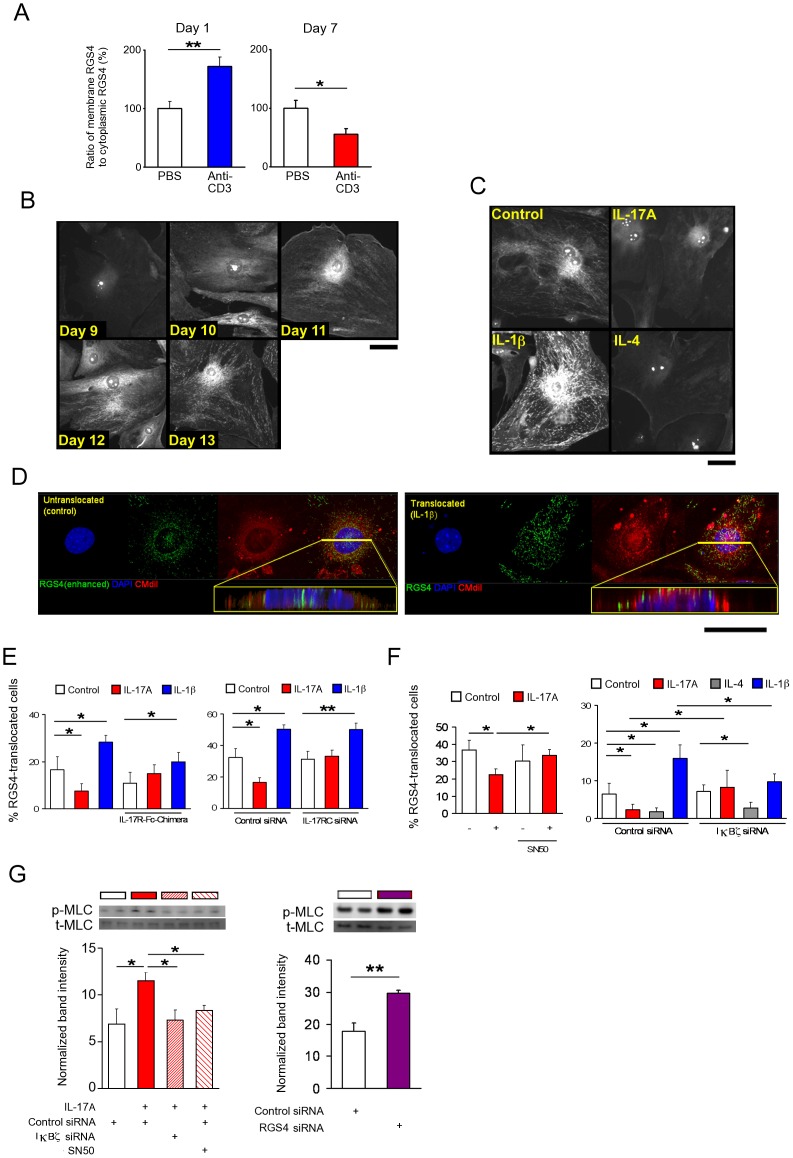
The effect of IL-17A on IκBζ - RGS4 signaling.(A) RGS4 activity in samples of MS isolated from the mice treated with PBS or αCD3. RGS4 activity was estimated as the ratio of membrane RGS4 to cytosolic RGS4 as described in Materials and Methods. In the inflammatory phase (Day 1) RGS4 activity was enhanced while in the recovery phase (Day 7) the activity was decreased (n = 8). (B) Immunofluorescence staining of RGS4 protein. The days from the beginning of the culture are indicated. Scale bar, 50 µm. (C) Immunofluorescence staining of RGS4 protein after treatment with IL-17A, IL-1β or IL-4 for 24 hrs. Scale bar, 50 µm. (D) Three dimensional reconstruction of laser confocal microscopic images of cultured SMCs treated with IL-1β (right panel) and control (left panel). Cross-sectional images are included. Scale bar, 50 µm. (E) RGS4 activity was assessed by calculating the ratio of the cells with punctate RGS4 immunosignals. The effect of IL-17A or IL-1β with or without L-17RFcChimera or IL-17RC siRNA was examined (n = 4∼5). (F) The effect of IL-17A, IL-1β, or IL-4 on RGS 4 activity was assessed with or without SN50, a p65 translocation inhibitor, or IκBζ siRNA (n = 4∼5). (G) Quantitation of p-MLC by immunoblot analysis. The ratio of p-MLC to total MLC was calculated as described in Materials and Methods. N means the number of wells prepared from a mixed single lot of SMCs derived from 24 mice. The experiment was repeated and essentially the same results were obtained. The left panel shows the effect of SN50 or IκBζ siRNAs on the IL-17A-induced increase in p-MLC (n = 3∼4). The right panel shows the effect of RGS4 siRNAs on the p-MLC (n = 3). Numerical data represent means ± s.e.m. *P<0.05, **P<0.01, Student's t-test under the closed testing procedure for multiple comparison (A, E–F).